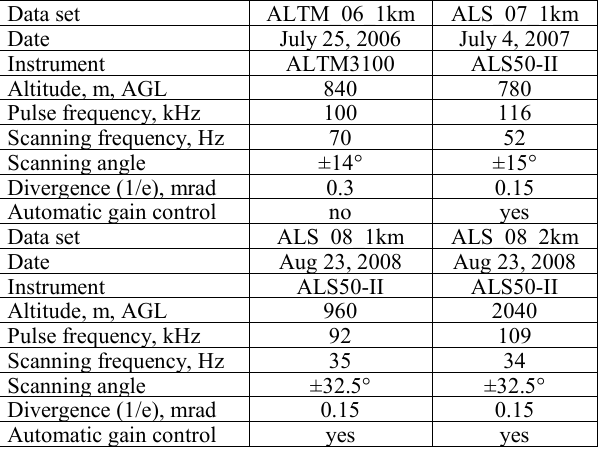
Fig. 2. Map of trees on plot A (left) and B (right). The symbol size for upper layer trees depicts h rel . Coordinates are in meters (KKJ-2 system). Table 2. Sensor configurations in the LiDAR data sets.